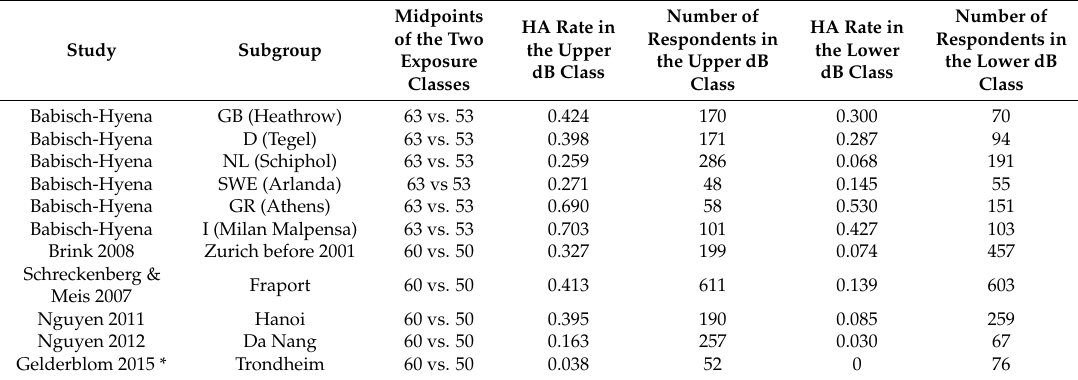
Table 2. Air traffic noise—HA rates and the number of respondents in two classes of exposure ( L den ). Midpoints of the Study Subgroup